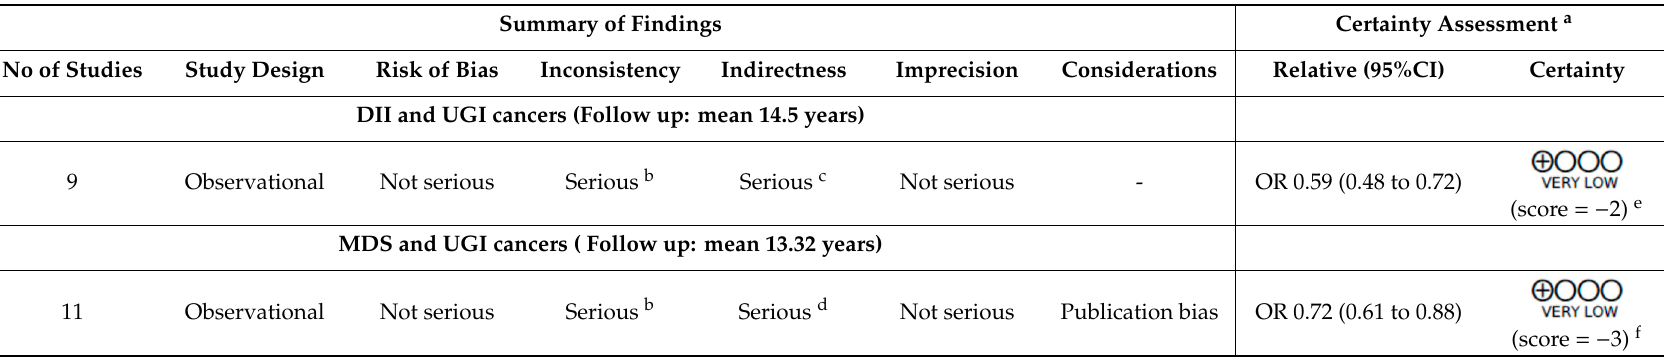
Table 2. The overall quality of evidence diet quality quantified by dietary indices and risk for UGI cancers in pooled findings from eligible studies. Summary of Findings